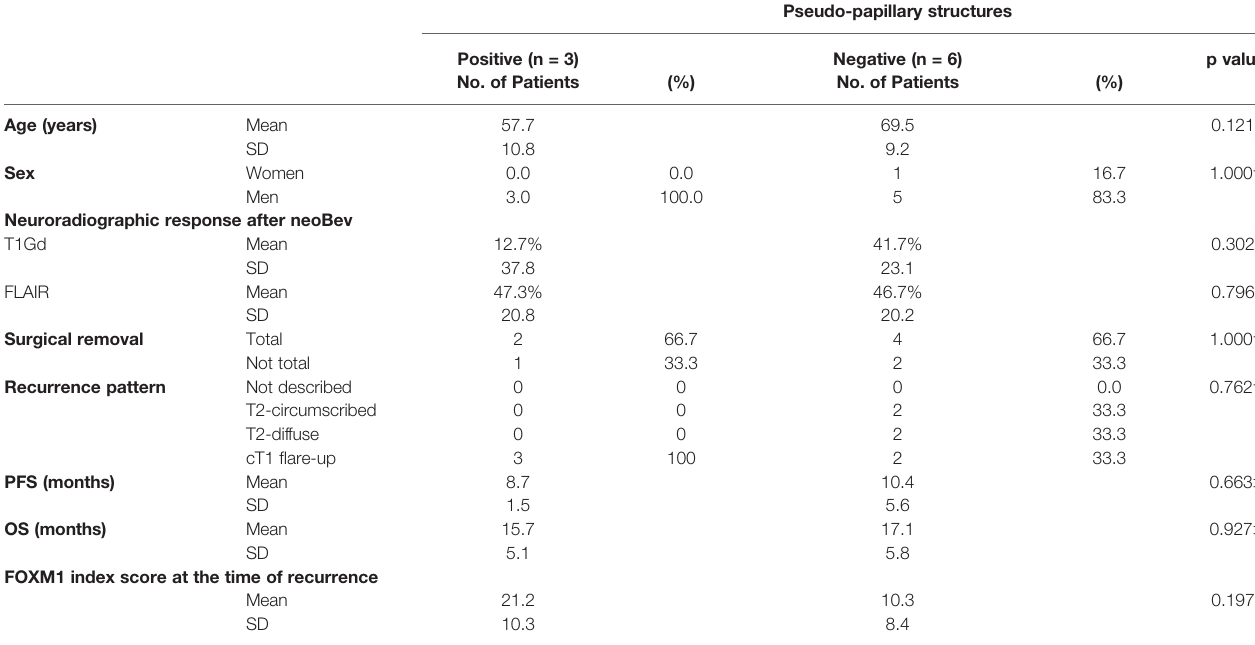
Pseudo-papillary